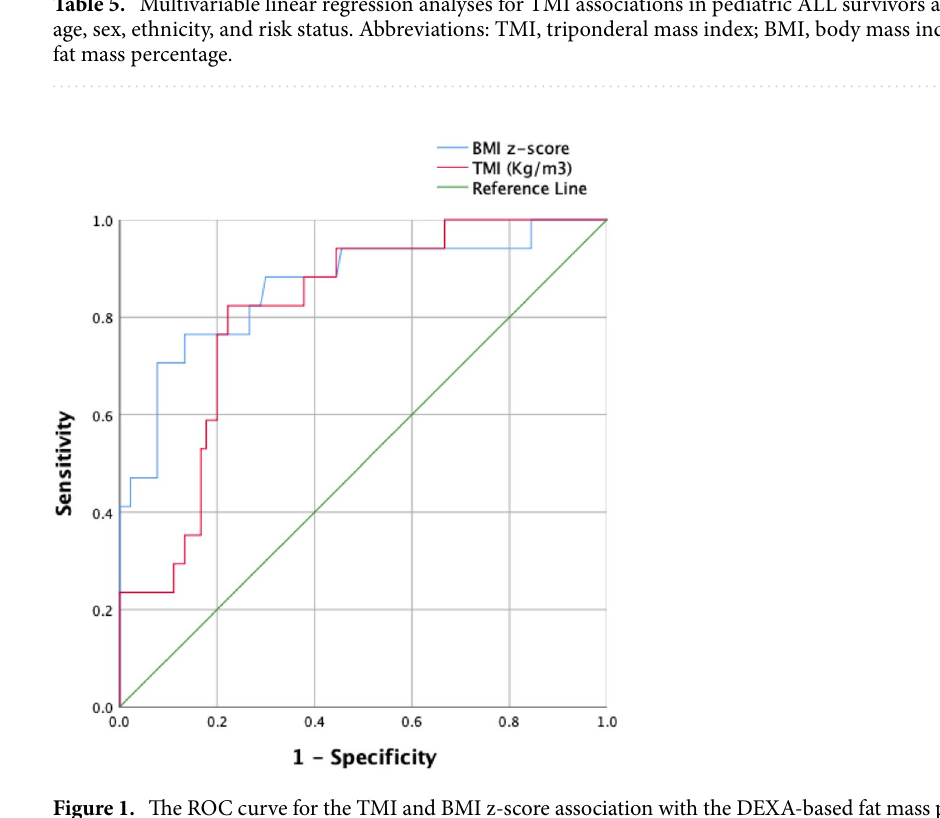
Figure 1. The ROC curve for the TMI and BMI z-score association with the DEXA-based fat mass percentage